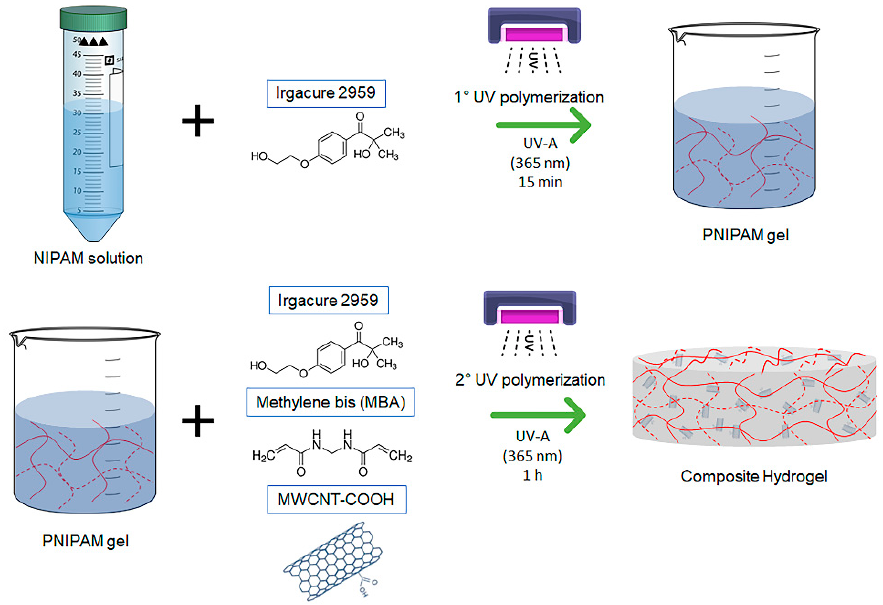
Figure 1. Scheme of the synthesis of PNIPAM/MWCNT-COOH hydrogel by two-step photopolymerization under UV light.